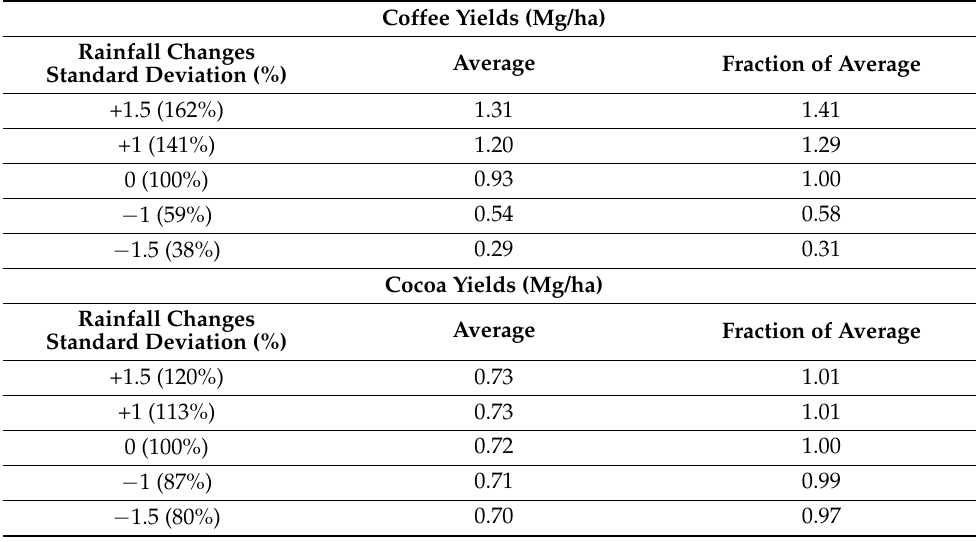
Table 9. Sensitivity analysis of yield responses to changes in